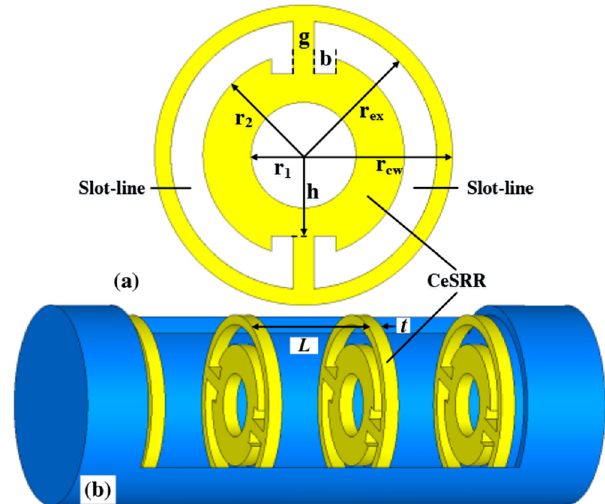
Fig. 5. (a) CeSRR unit cell and (b) 3-gap MTM EIRC, where r 1 = 6.5mm, r 2 = 12mm, r ex = 16.5mm, r cw = 18.5mm, g = 2.6mm, b = 3mm, t =2.5 mm, and h = 9.5mm